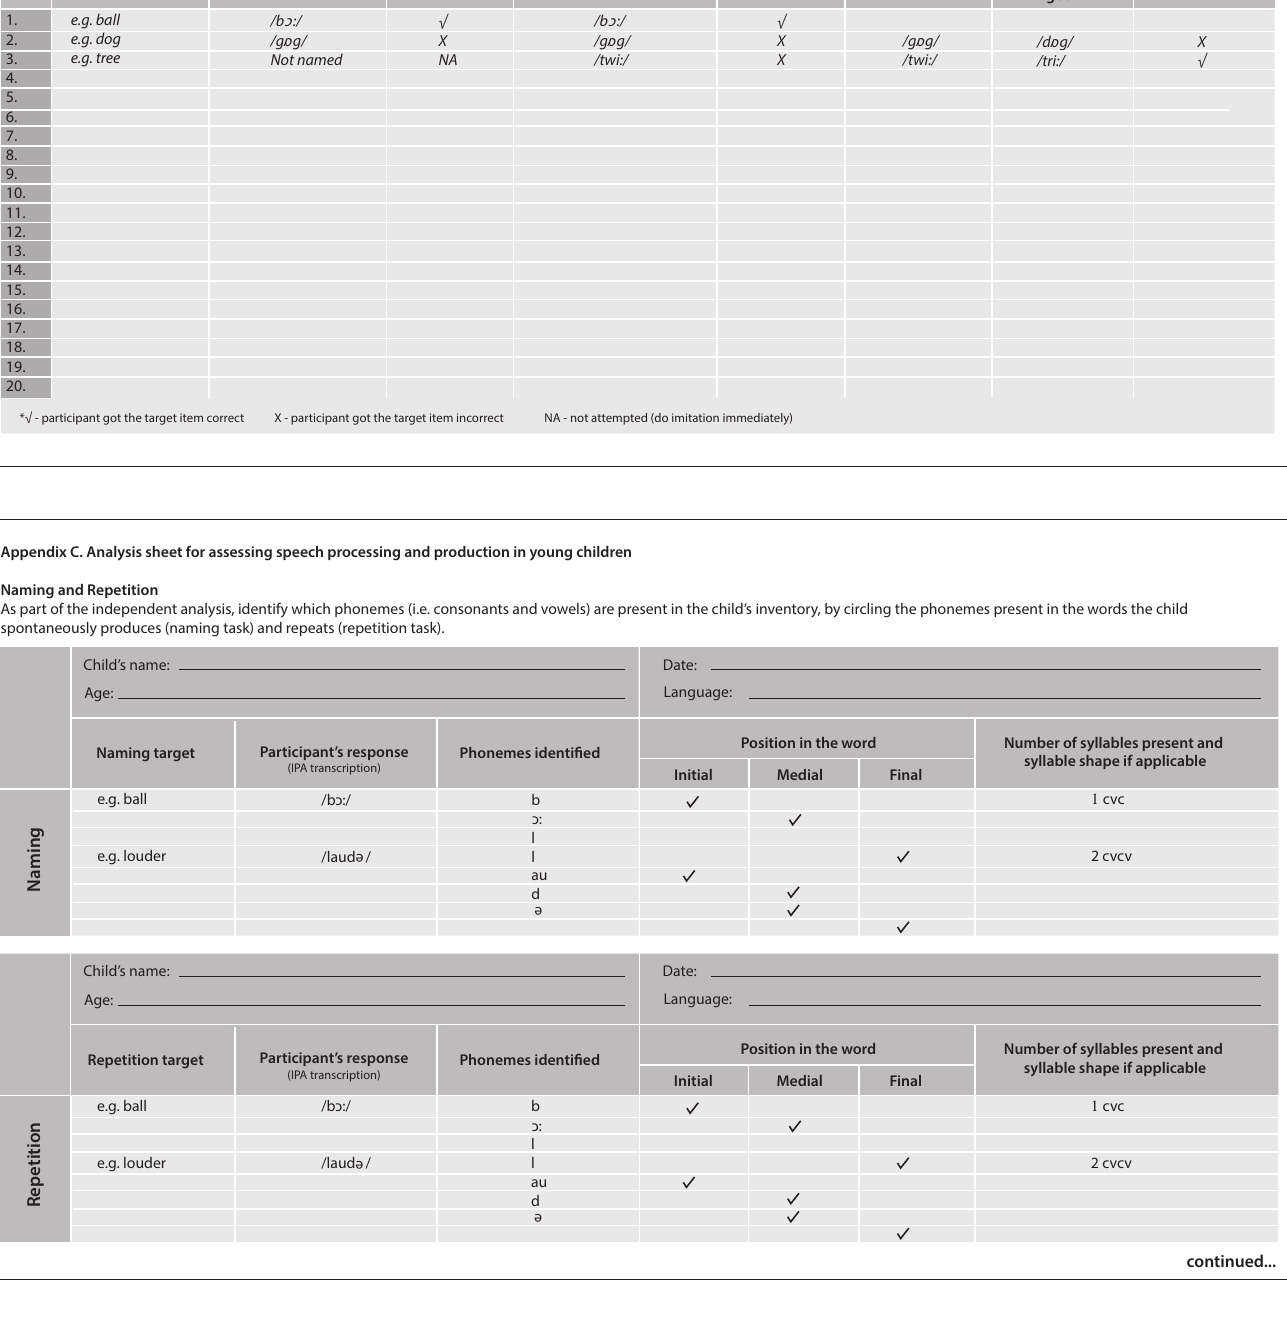
Repetition task